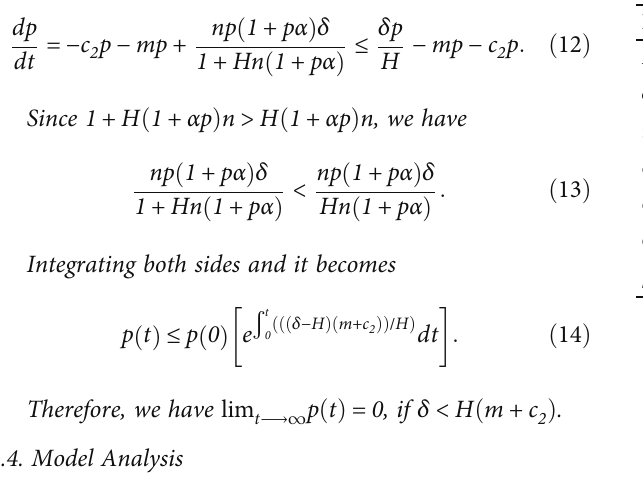
Table 2: Parameter value of system